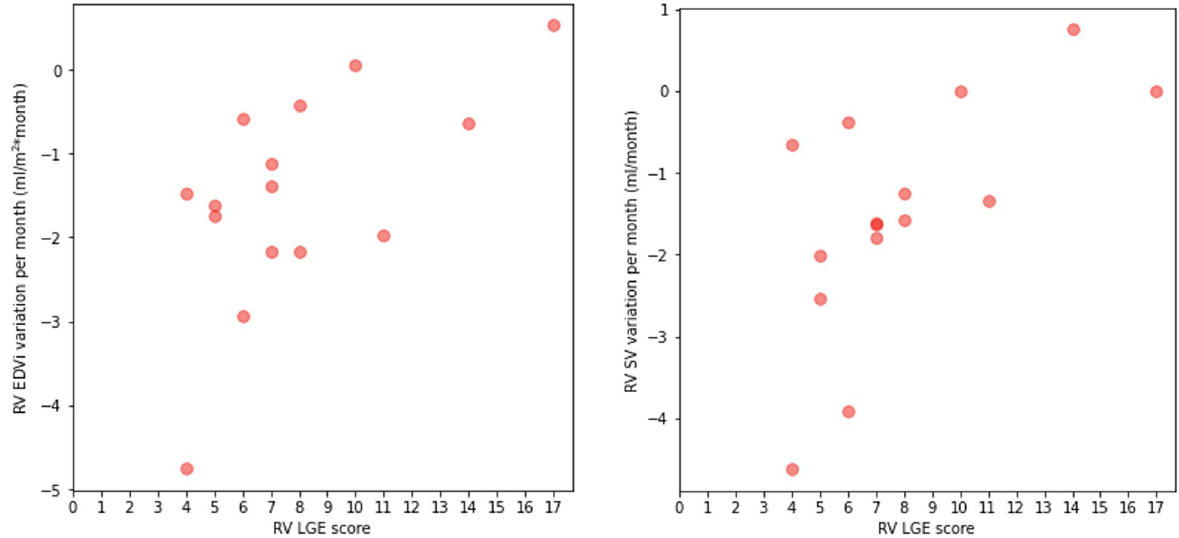
Fig. 4 Scatterplots depicting the correlations between right ventricular (RV) late gadolinium enhancement (LGE) score and the monthly variation of RV end-diastolic indexed volume (EDVi) and RV stroke volume (SV),